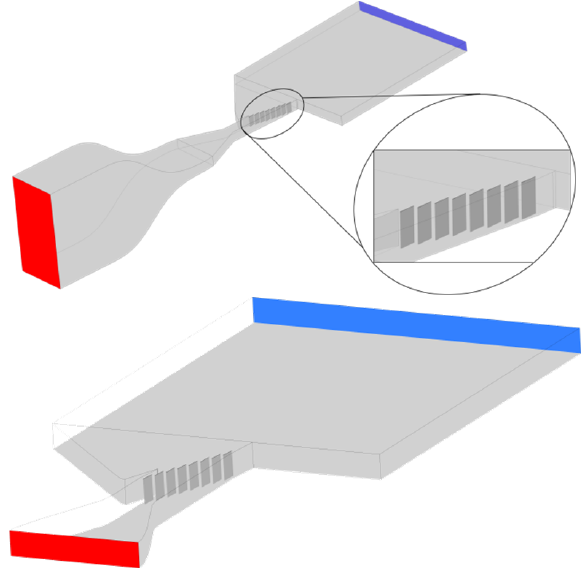
Figure 7. CFX computational domain for steady- state simulations (up) and unsteady simulations (down).